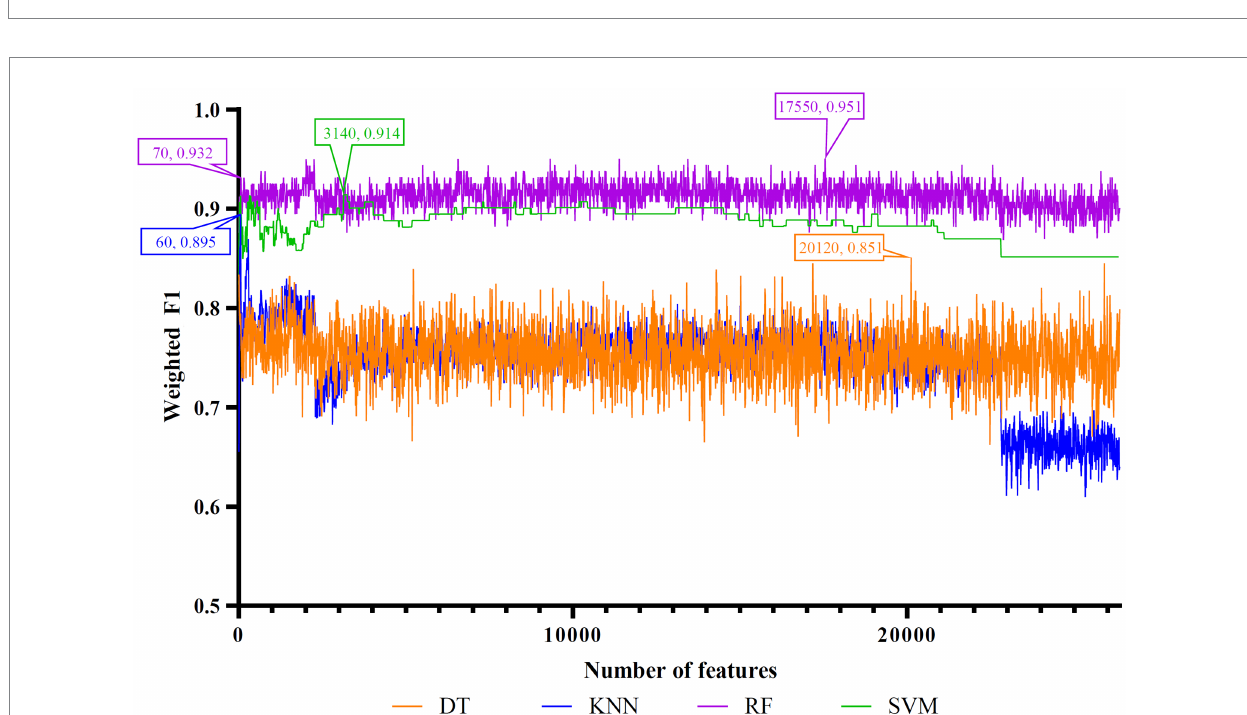
FIGURE 4 IFS curves of four classification algorithms on MCFS feature list. DT, KNN, RF and SVM yielded the highest weighted F1 values of 0.851, 0.895, 0.951, and 0.914 when top 20,120, 60, 17,550, and 3,140 features were adopted, respectively. RF can yield quite high performance (weighted F1 = 0.932) when top 70 features were used.